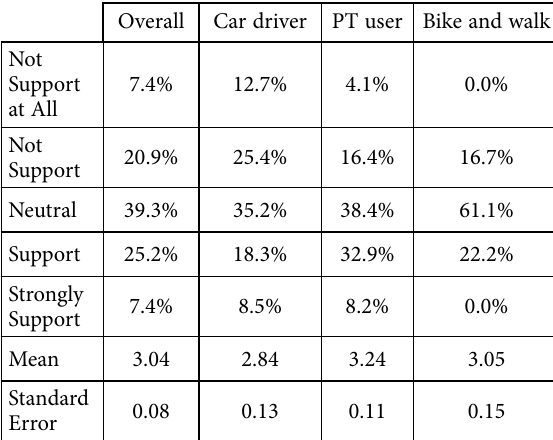
Table 5. Public acceptance rate on a new scheme Overall Car driver PT user Bike and walk